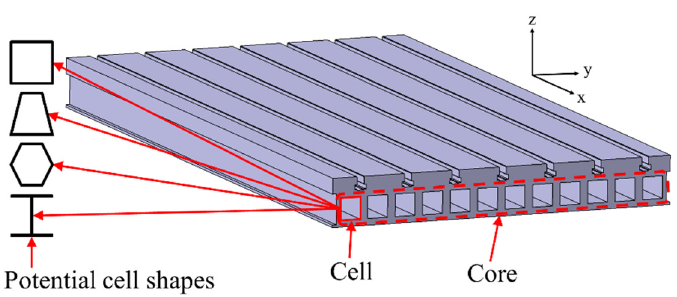
Figure 3. Sandwich panel table with a core of square cells, adapted from Triebe et al. [33].